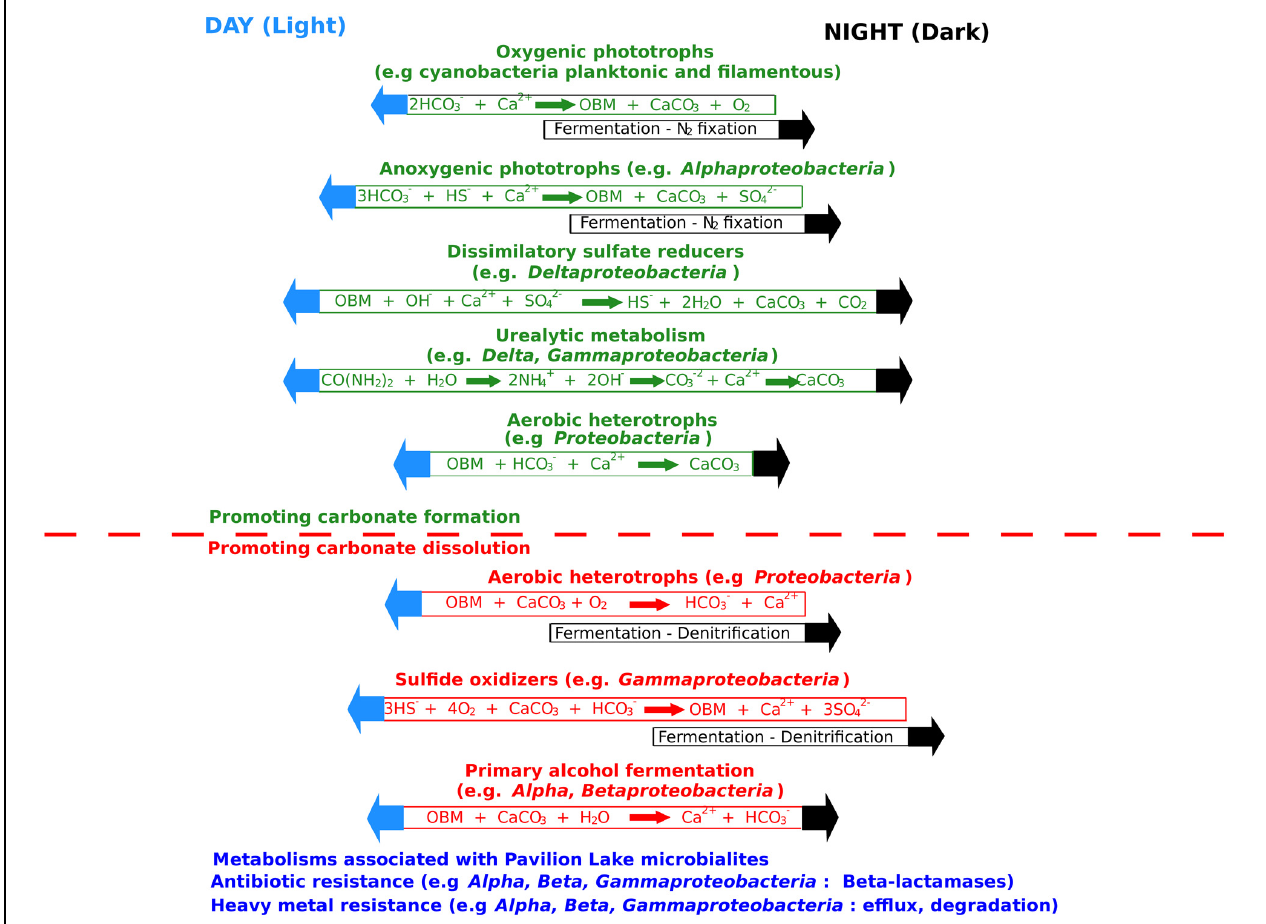
FIGURE 4 | A summary of the factors affecting carbonate precipitation and dissolution as inferred from the Pavilion Lake microbialite metabolic potential and community composition. OBM is organic biomass. Adapted from Dupraz et al. (2009).